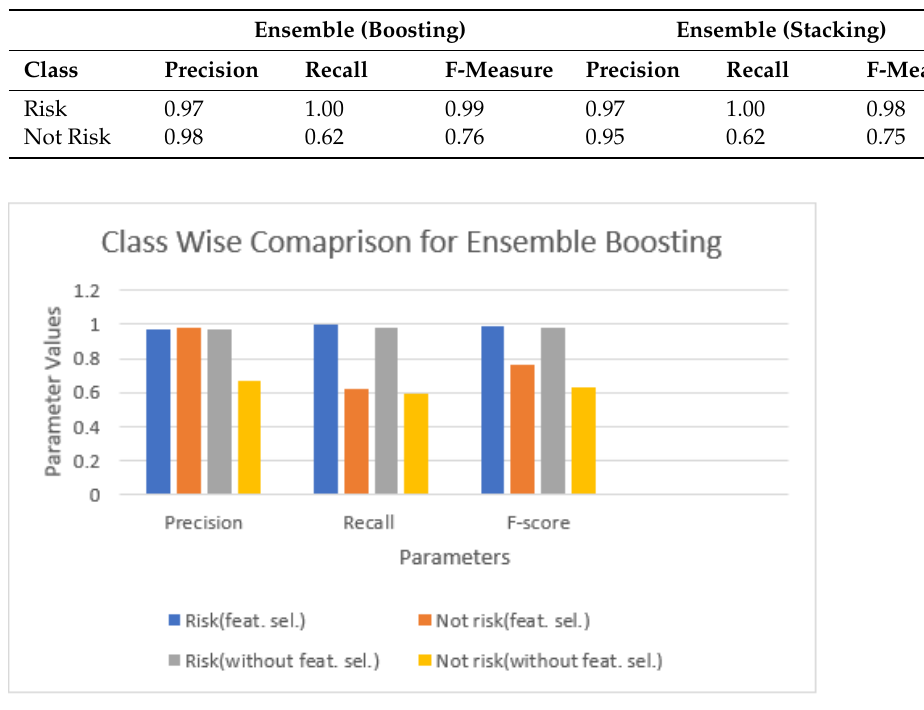
Figure 4. Comparison of performance metrics with or without Feature Selection for Boosting Process.